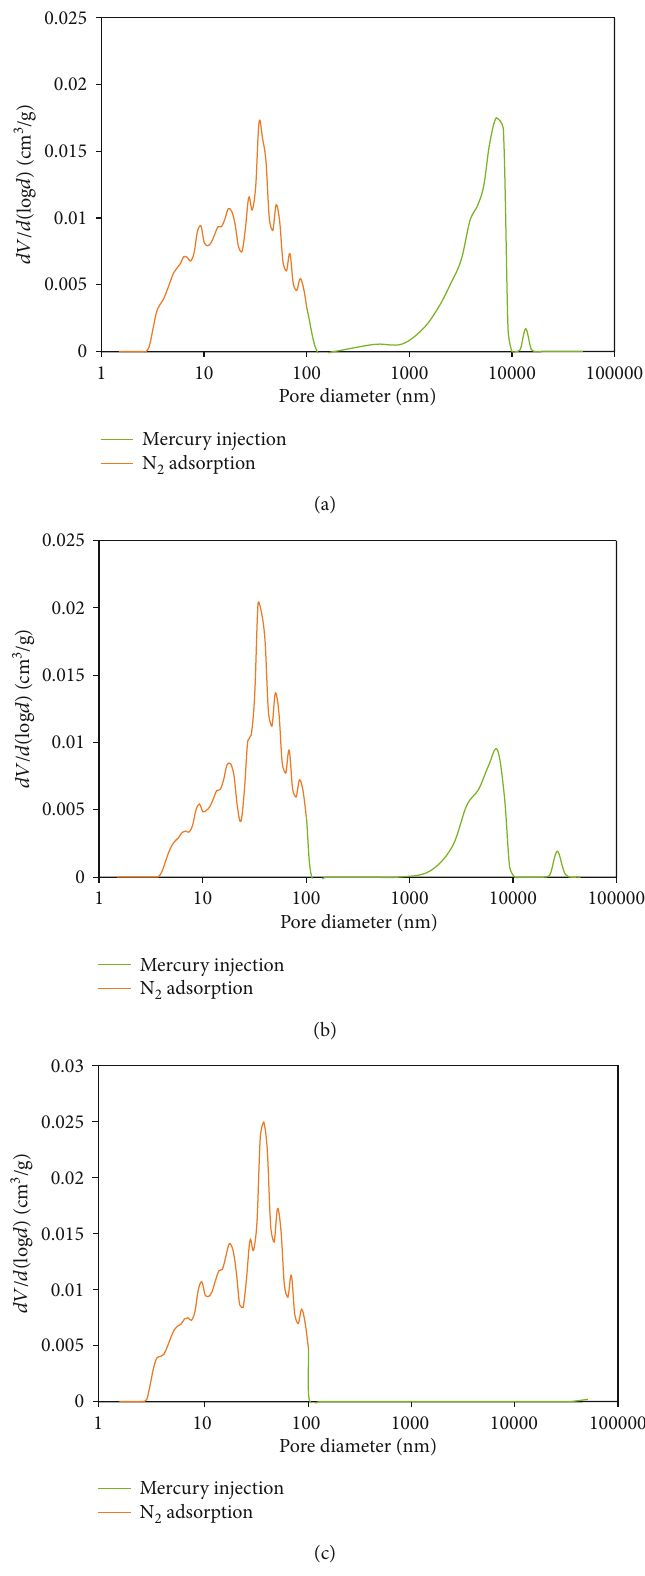
Figure 12: Combined pore size distribution of N